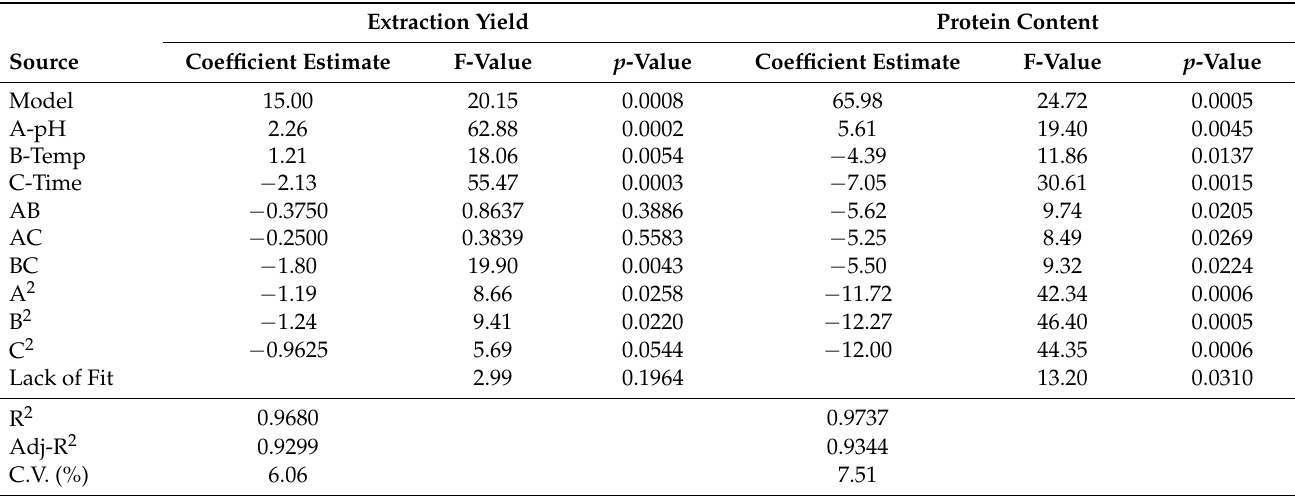
Table 2. Analysis of variance for the fitted second-order polynomial